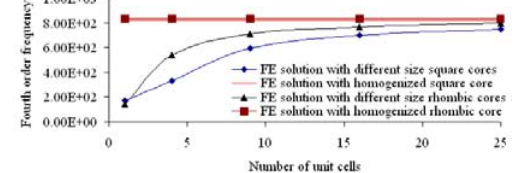
Fig.24. Frequency variation of the fourth order vibration with different size square and rhombic